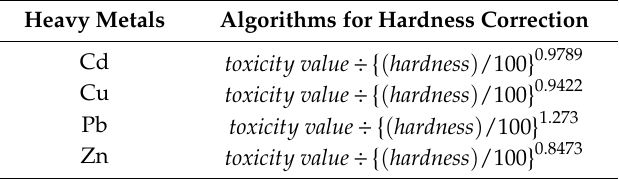
Table 2. The algorithms converting the metal toxicity values to water hardness of 100 mg / L as CaCO 3